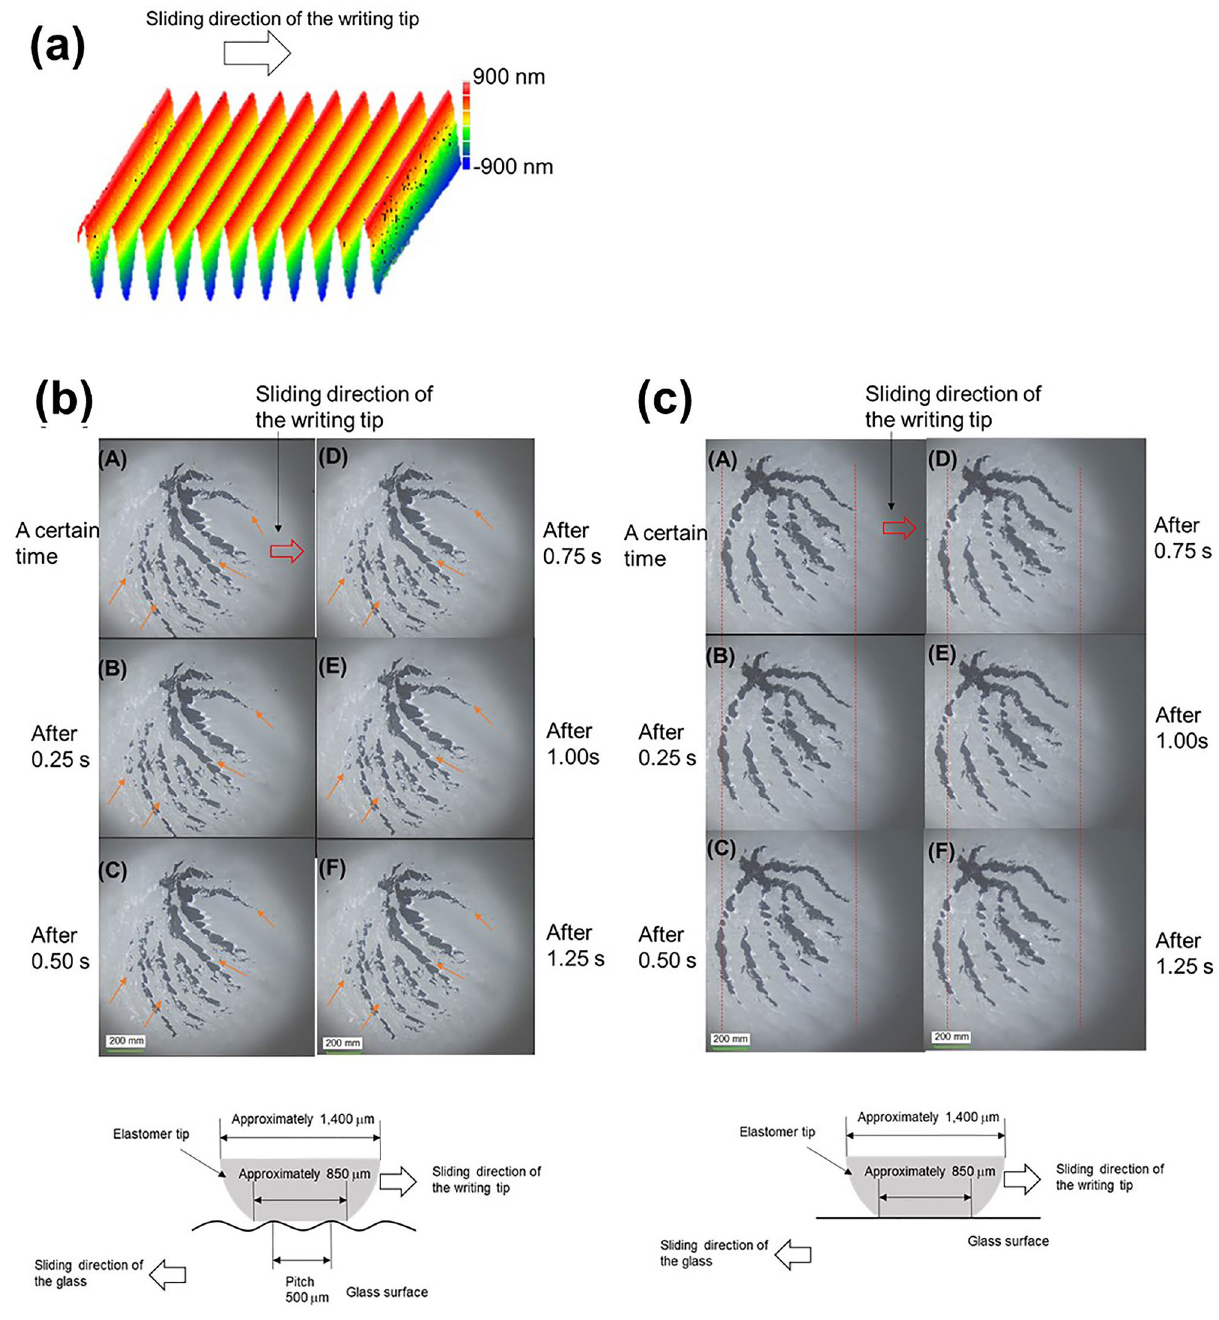
Figure 4. ( a) Stripe pattern with 500 μm spacing and 1463 nm of the height and sliding direction of the writing tips. ( b ),( c ) Observations of the contact area between the elastomer and glass surfaces during sliding motion (( b ) Stripe pattern with 0.5 mm spacing and 1463 nm, ( c ) flat glass), and illustration of the relationship between the elastomer and each glass